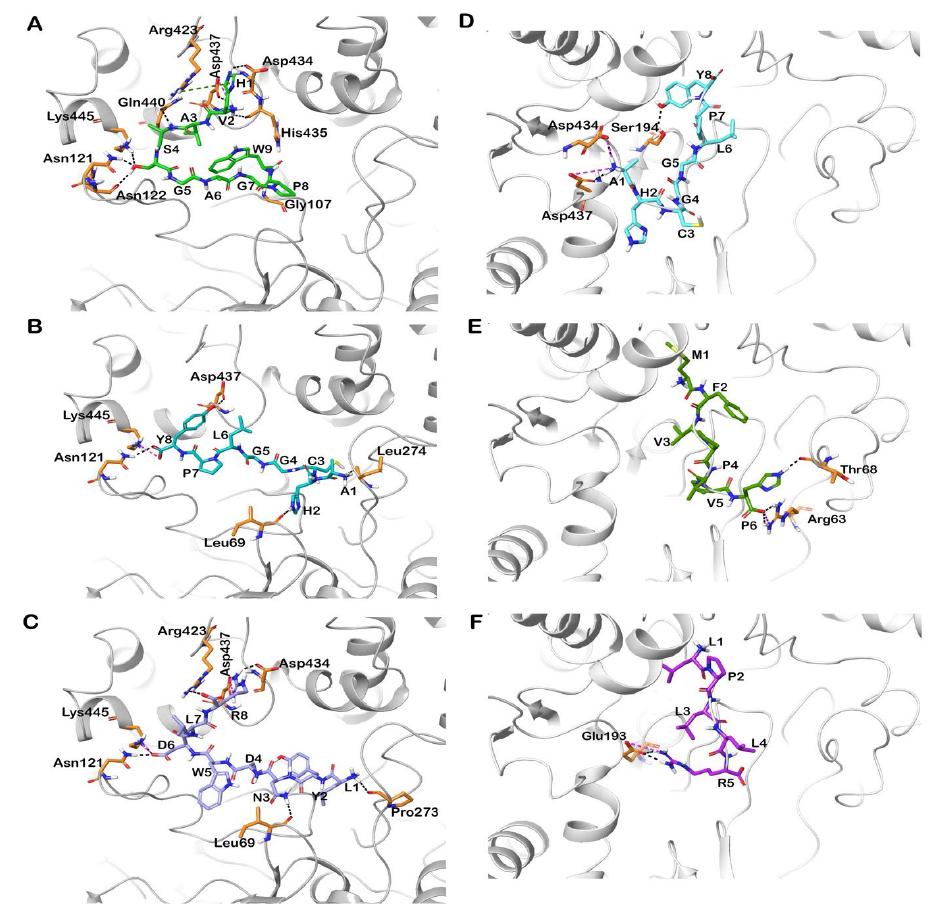
Figure 1. Docked poses of peptides in the active site of human and bovine CEase (PDB IDs: 1F6W and 1AQL). The protein is shown in cartoon representation and the docked peptides are shown in stick representation. The interactions of peptides ( A ) HVASGAGPW, ( B ) AHCGGLPY, ( C ) LYNDWDLR in the active site human CEase. Interactions of peptides ( D ) AHCGGLPY, ( E ) MFVPVPH and ( F ) LPLLR in the active site of bovine CEase. Hydrogen bonds, π - π stacking, π -cation interactions and salt bridges are represented in black blue, green and pink dashed lines. Keywords: Cholesterol esterase (CEase).